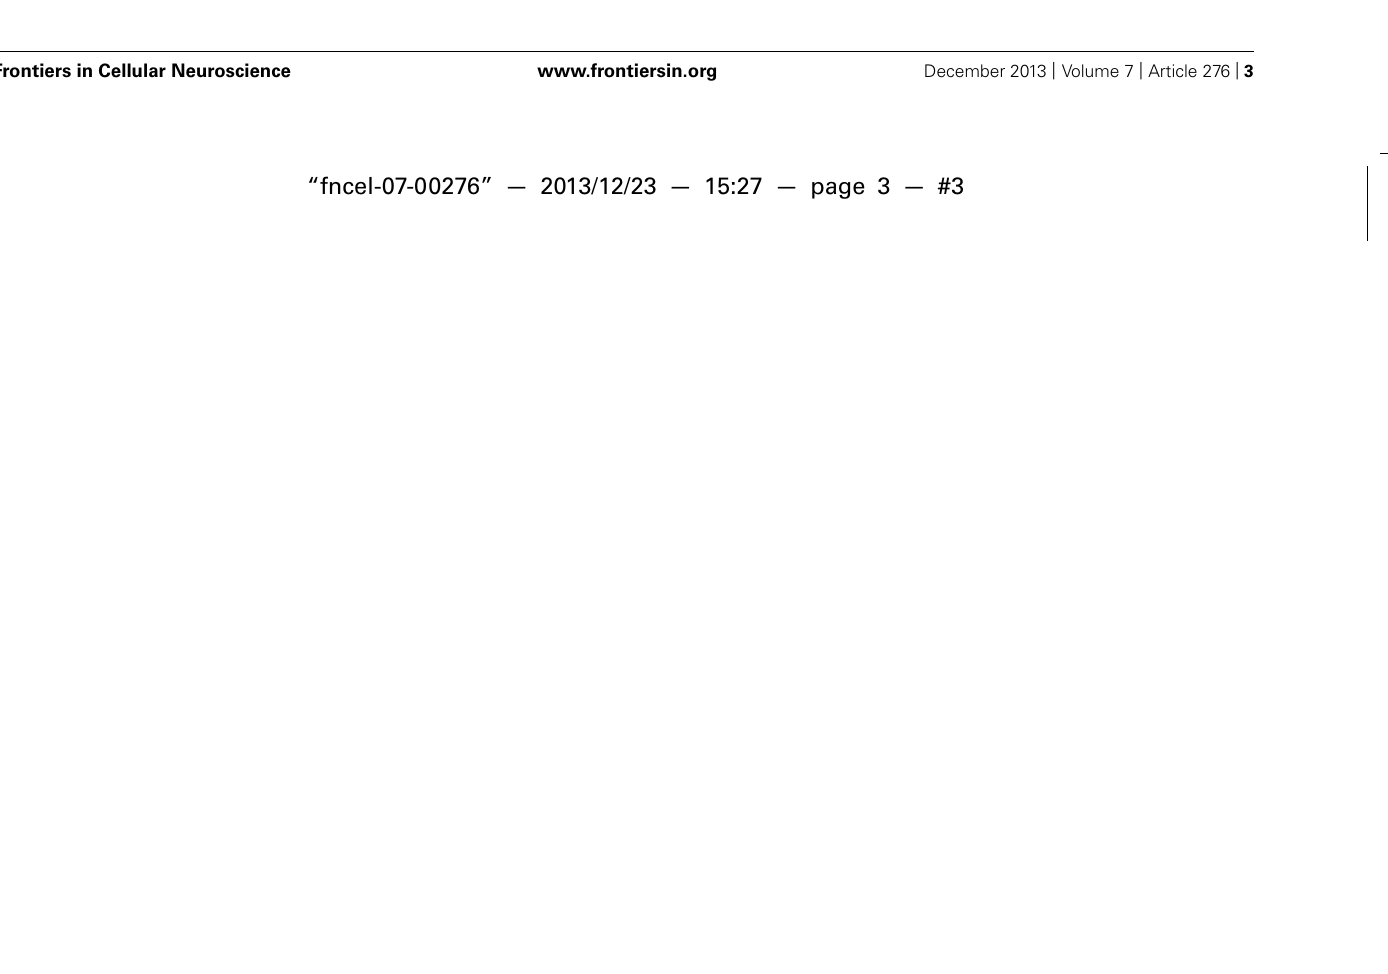
FIGURE 1 | Responses to mechanical stimulation in cells with LTS . (A) A depolarizing current pulse produced low-frequency tonic firing when applied at rest [ (a) , left] and a high-frequency burst when the cell was hyperpolarized with bias current [ (a) , right]. Application of a long-lasting current pulse (5 s) shows that the initial high-frequency burst is followed by sustained tonic firing (b) . (B) Responses of the cell shown in A to brush (a)